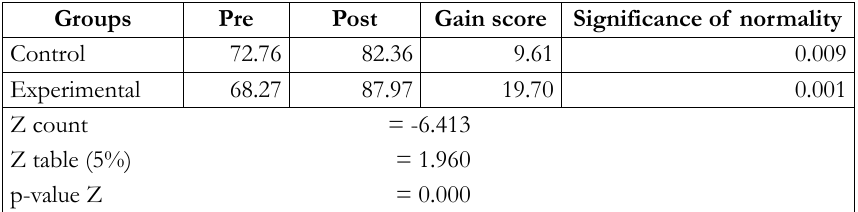
Table 6. The Mean Gain score of Environmental Project